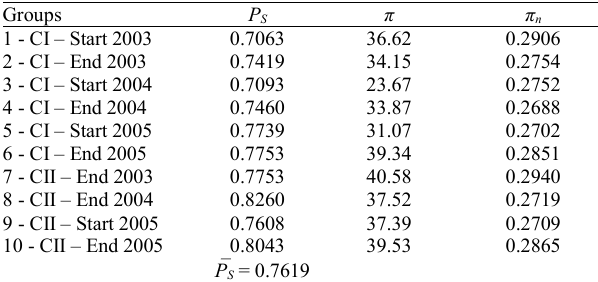
and the genetic analysis can be summarized in comparisons among the groups sampled. The AMOVA results (Table 3) on the genetic structure of L. elongatus for this second test showed a global F of 0.086 (P = 0) and estimates of F pair to pair ST ST (Table 4) with an amplitude of variation in its values from F = ST 0.033(P = 0.021) between the groups “CI - end 2003” and “CI - end 2004” to F = 0.141 (P = 0) between “CI - start of 2004” and ST “CII - end of 2004.” These pair-to-pair F estimates indicate a ST low to moderate genetic differentiation among the ten groups, based on the criteria adopted.